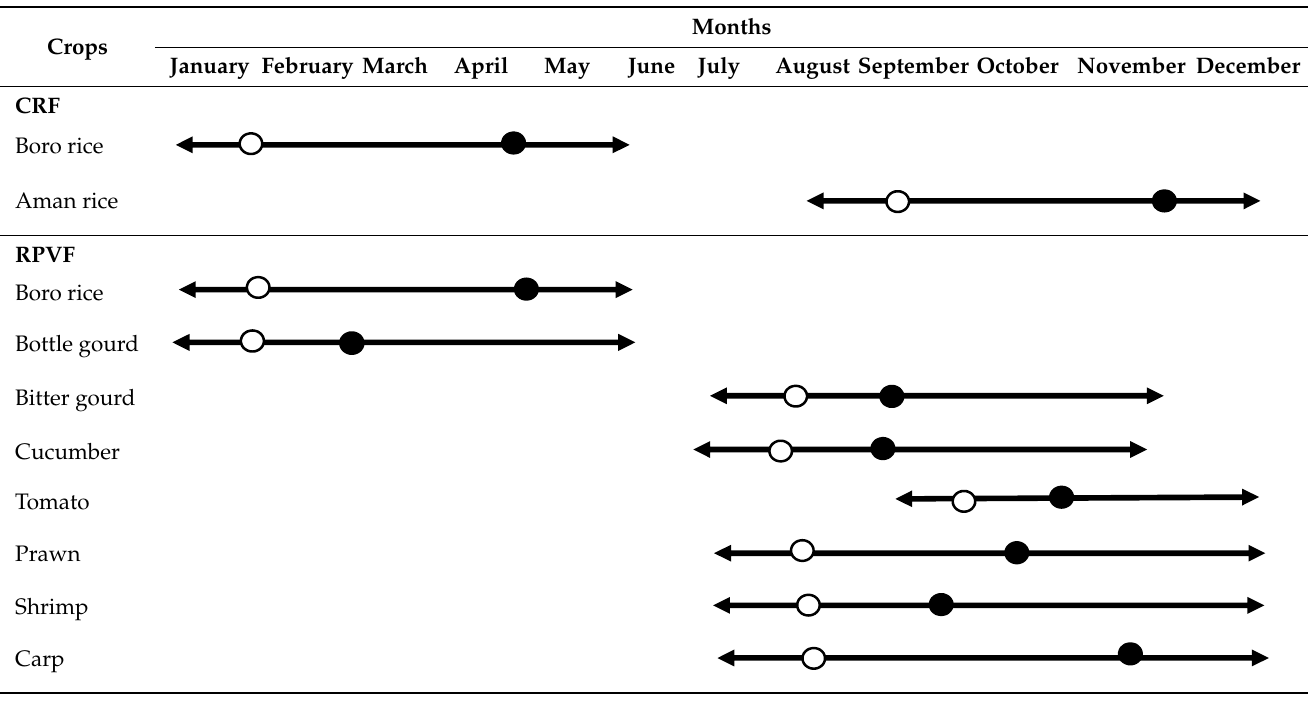
indicates starting of harvesting period.